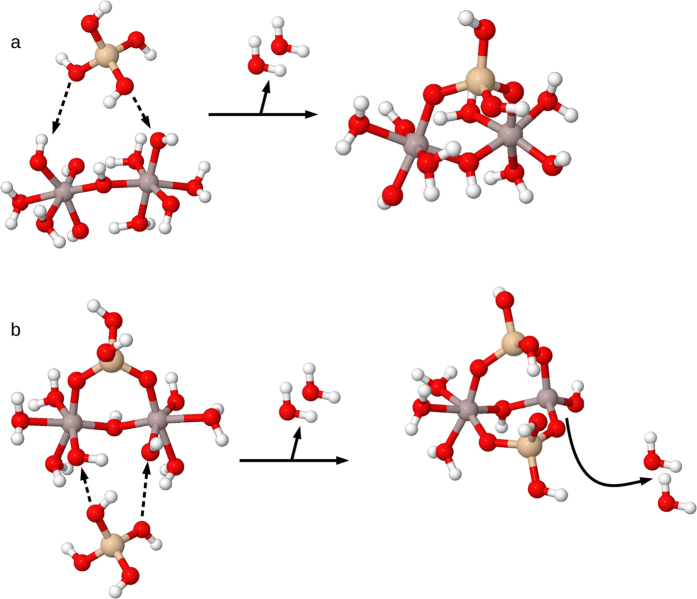
Binding of silicic acid molecule to (a) an aluminium hydroxide dimer to form HASA, and (b) a HASA unit to form HASB.